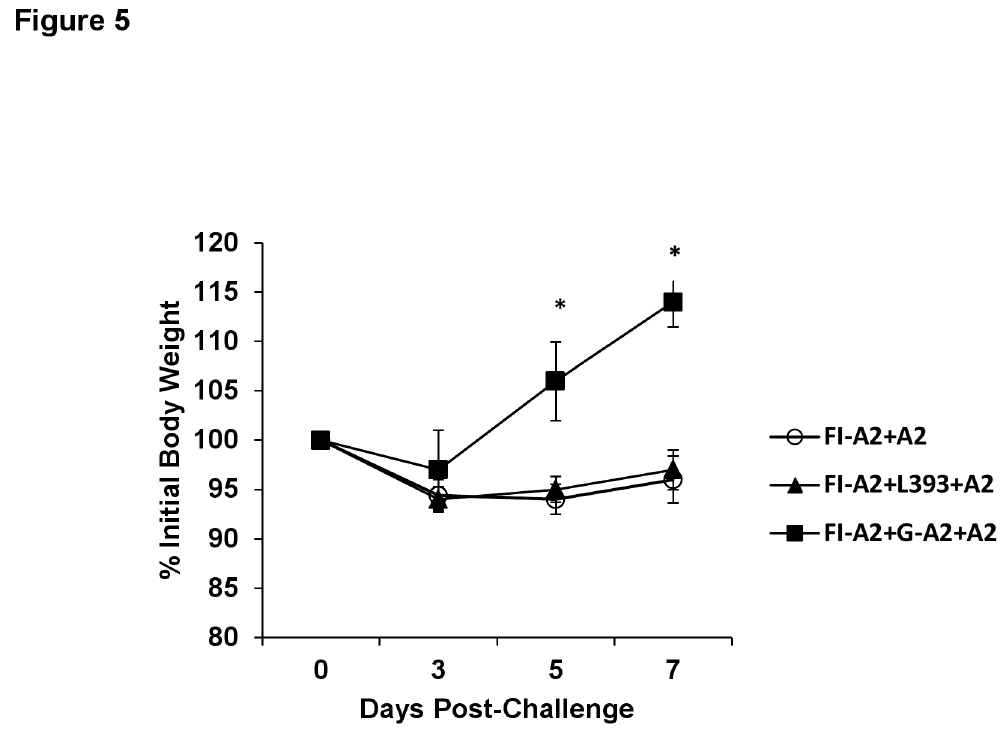
Figure 5. Decreased weight loss in FI-A2 and G-A2 peptide vaccinated mice after RSV challenge. Mice were i.m. vaccinated with formalin inactivated RSV A2 (FI-A2) and then s.c. vaccinated with G-A2 or control peptides. Two weeks following the final peptide boost, FI-A2 and RSV A2 G peptide (FI-A2+G-A2) and control L393 peptide (FI-A2+L393) mice were challenged with 10 6 PFU live RSV A2 and percent body weight loss were determined. Five independent experiments were performed and combined (representative) data from two experiments are shown. * p<0 . 05